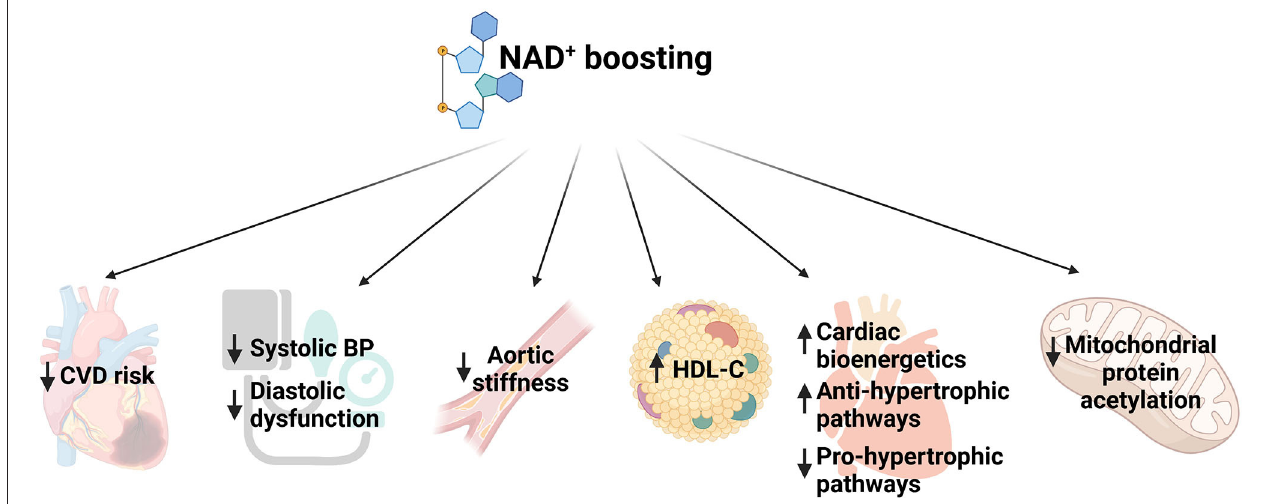
FIGURE 1 | Schematic representing function of NAD + boosting in multiple aspects of cardiovascular diseases. CVD, cardiovascular disease; BP, blood pressure; HDL, high density lipoprotein.